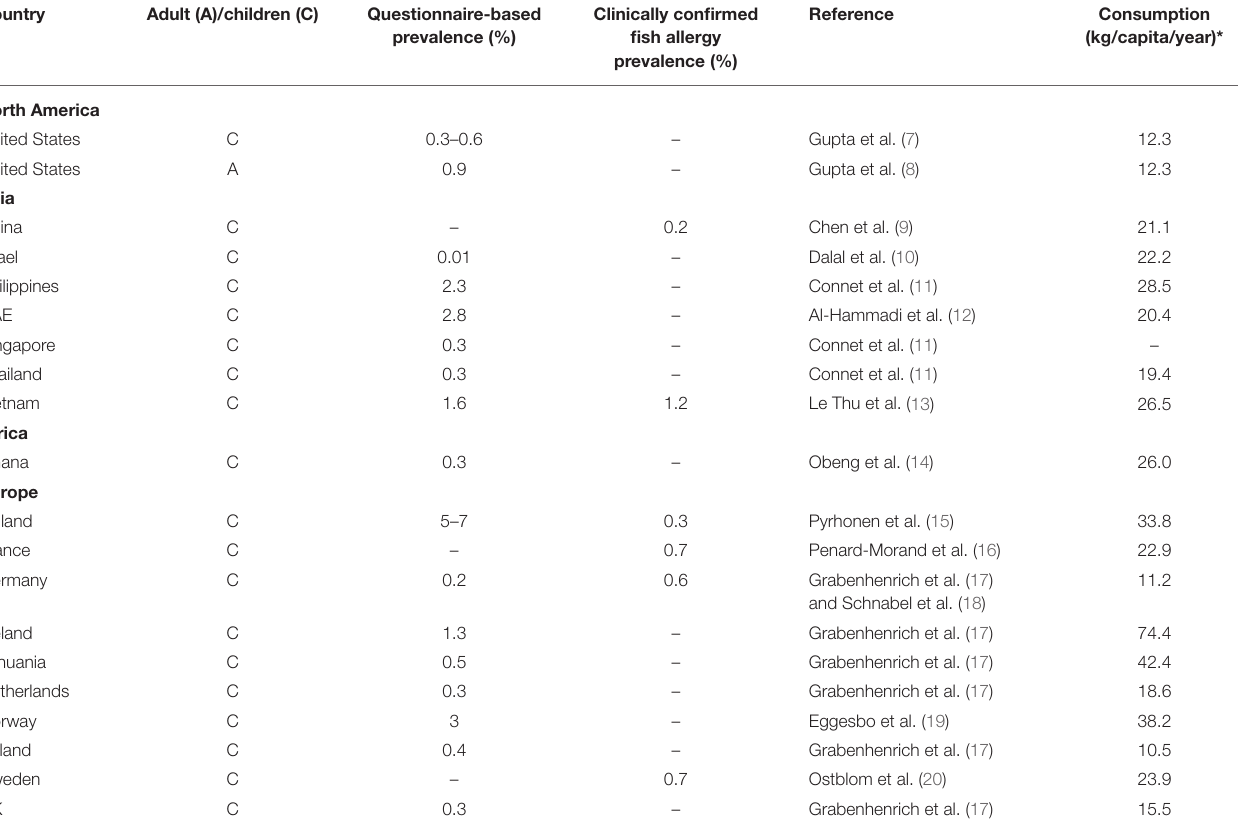
TABLE 1 | Fish allergy prevalence and fish consumption.